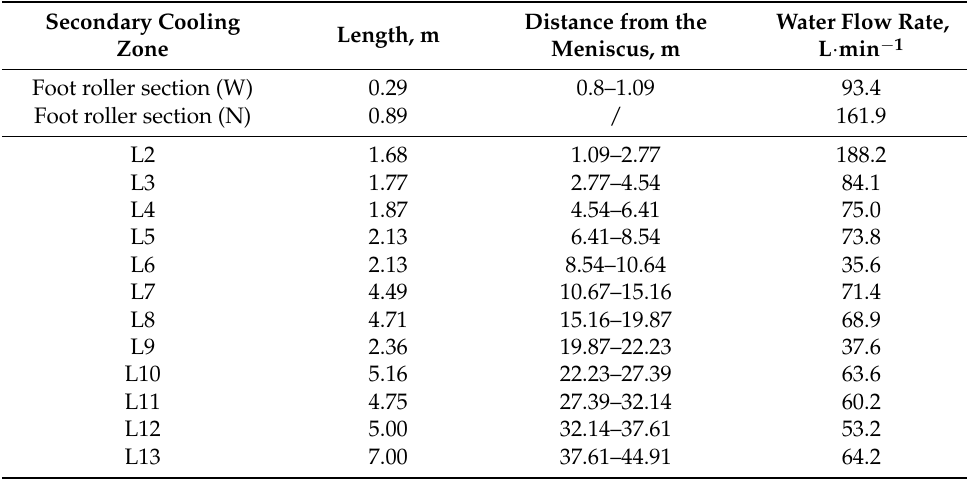
Table 4. Parameters at different sections of secondary cooling